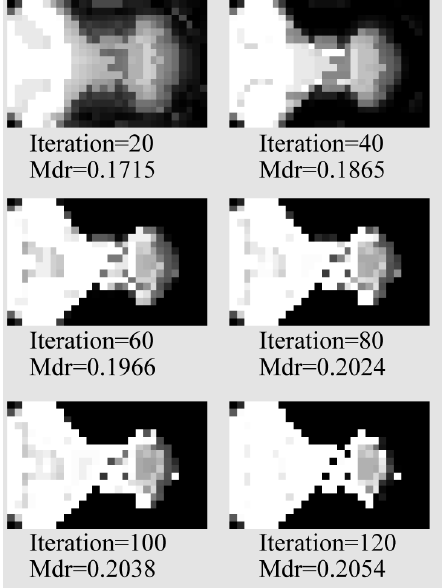
Fig. 9. Optimal distribution of damping material at different iteration numbers, vf = 0.6.